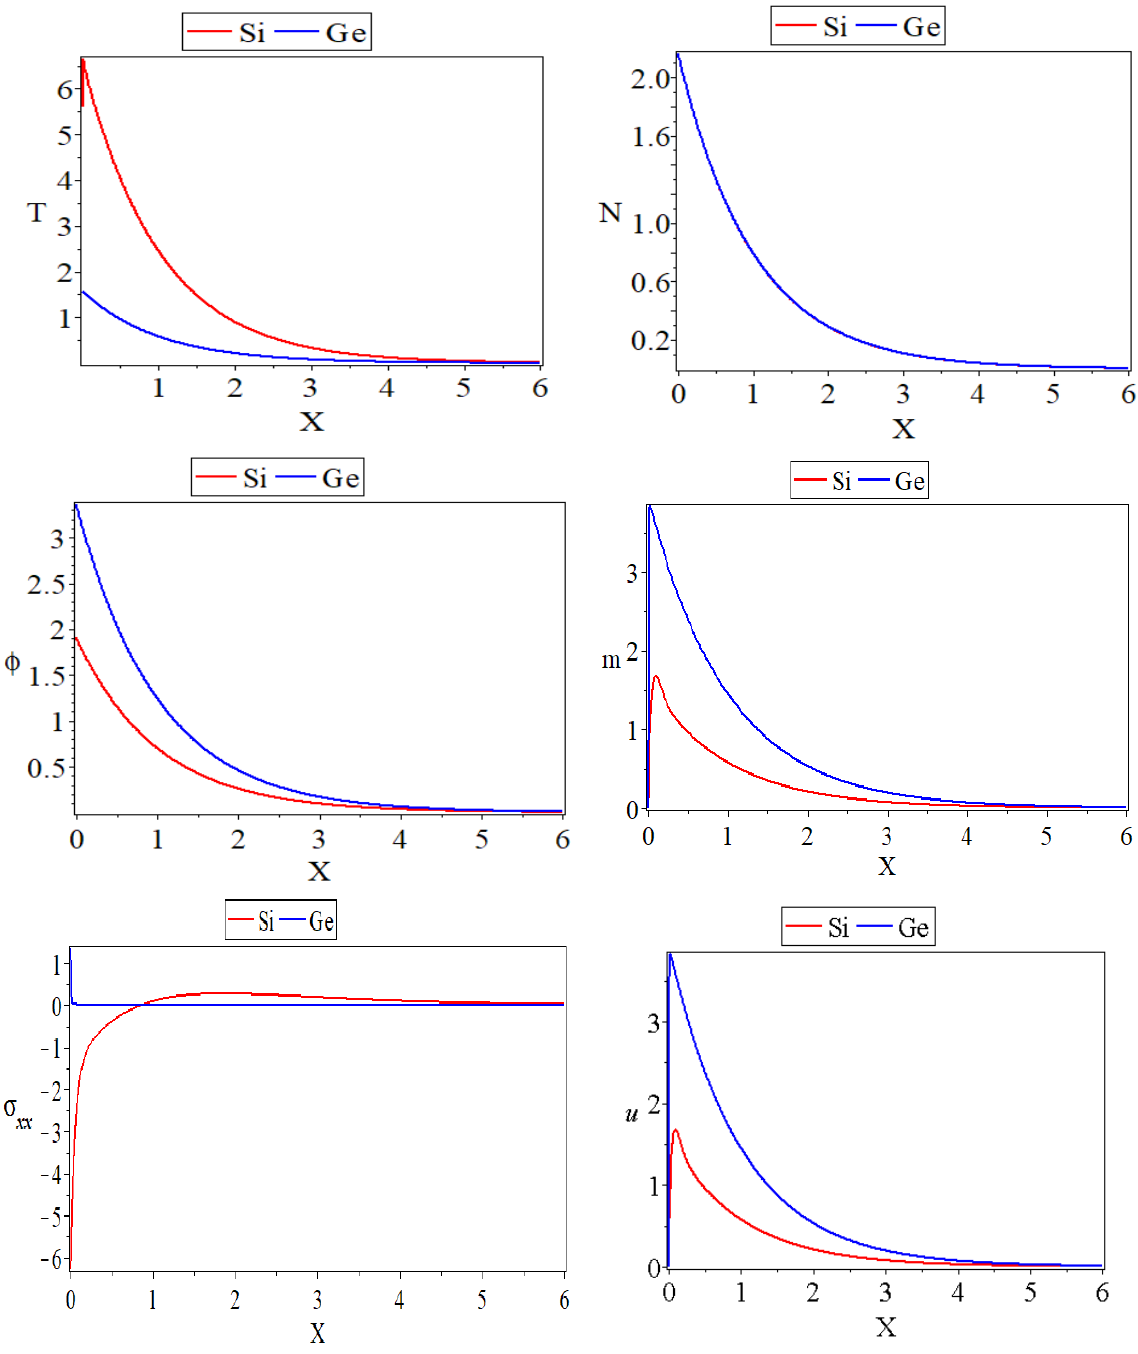
Figure 5. The comparison between Si and Ge materials of physical field distributions with distance under the effect of moisture field when ε 1 = 0.001 and ε 3 = − 7.8 × 10 − 36